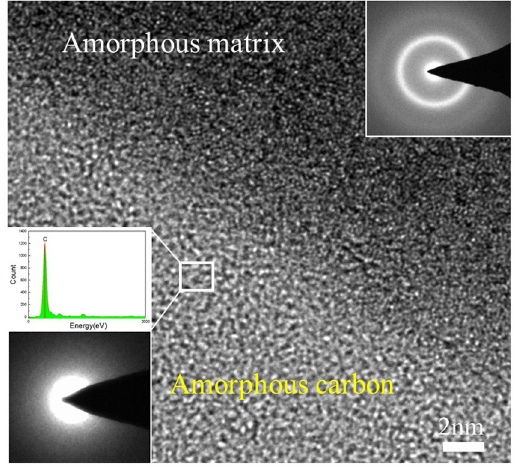
Figure 3. High-resolution TEM image on the interfacial structure between the amorphous matrix and amorphous carbon. Insets are the corresponding SAED patterns from the two phases and an EDX pattern from the amorphous carbon.